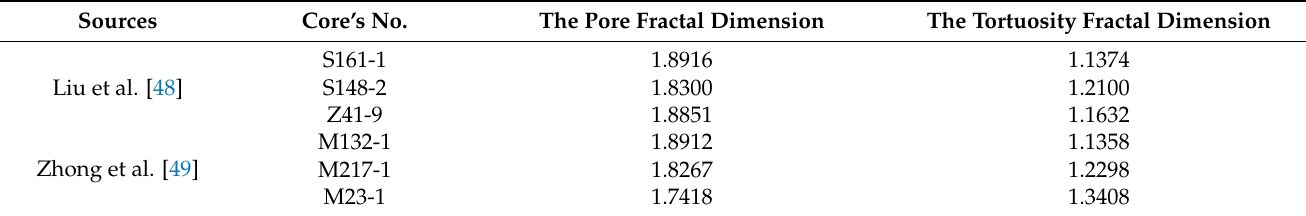
Table 2. The pore fractal dimension and the tortuosity fractal dimension.